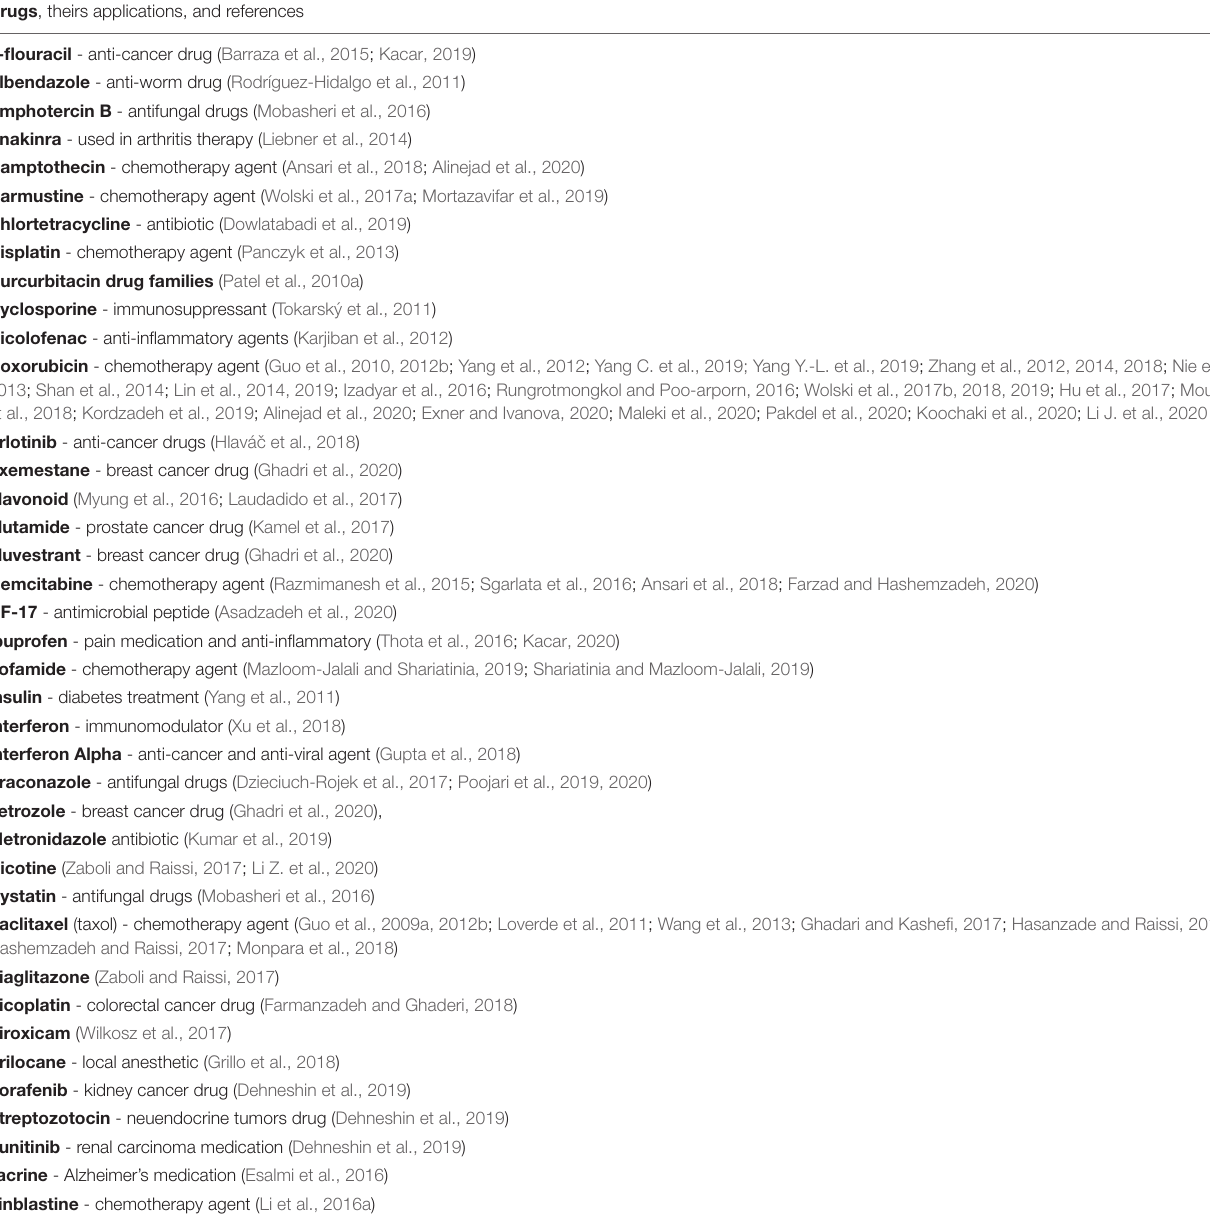
TABLE 3 | List of drugs studied with MD simulations in context of drug